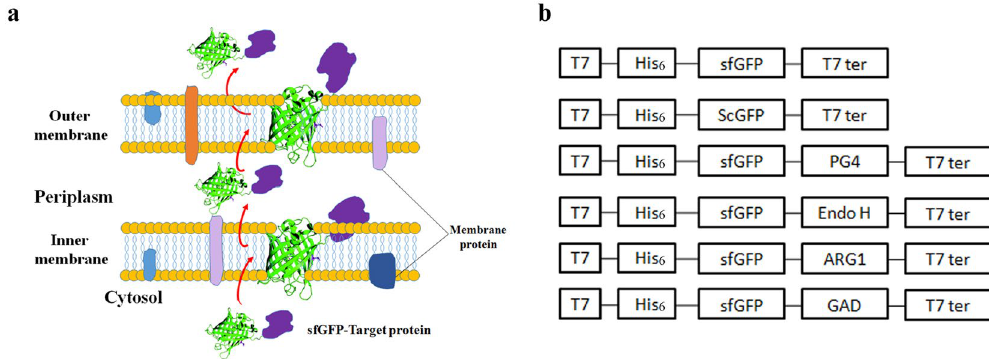
Figure 1. Diagrammatic sketch. ( a ) Possible secretory mechanism ofthe sfGFP fusion protein; ( b ) Constructs generated in this study; T7: T7 promoter; His 6 : 6 × His epitope tag; sfGFP: superfolder green fluorescent protein; scGFP: super charging green fluorescent protein; PG4: antibacterial peptide PG4; Endo H: endo-beta- N-acethylglucosamindase H; ARG1: human arginase-1; GAD: Glutamate decarboxylase; T7 ter: T7